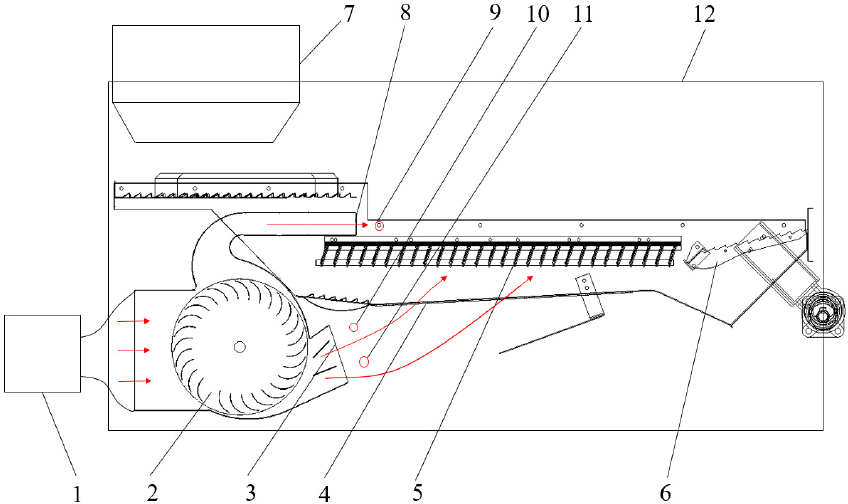
Figure 3. Sketch diagram of hot airflow. Cleaning test: 1. heater; 2. cross-flow fan; 3. lower gas outlet; 4. woven screen; 5. louvre screen; 6. tail screen; 7. hopper; 8. upper air outlet; 9. test point 1; 10. test point 2; 11. test point 3; 12. cleaning room.